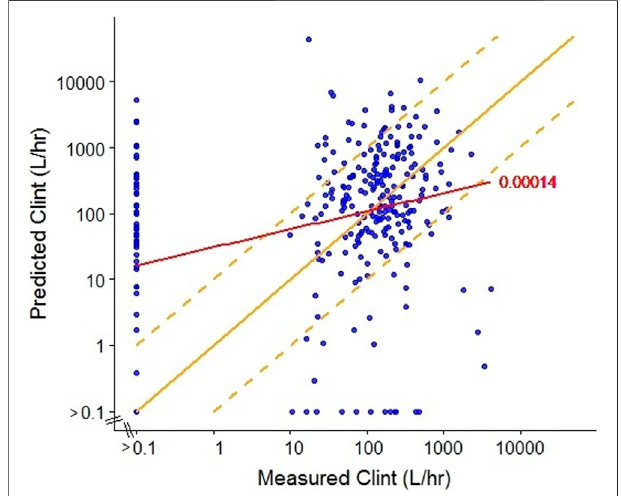
FIGURE 1 | Comparison of measured (Wetmore et al., 2015) and predicted (ADMET predictor, ver7.1, SimulationsPlus) intrinsic clearance (CL int ) for a subset of ToxCast chemicals. The red line represents the linear regression with R 2 = 0.00014. The solid yellow line represents equivalence between predicted and measured values (y = x) and the dashed yellow lines represent a 10-fold divergence between predicted and measured values (y = 10 × x; y =